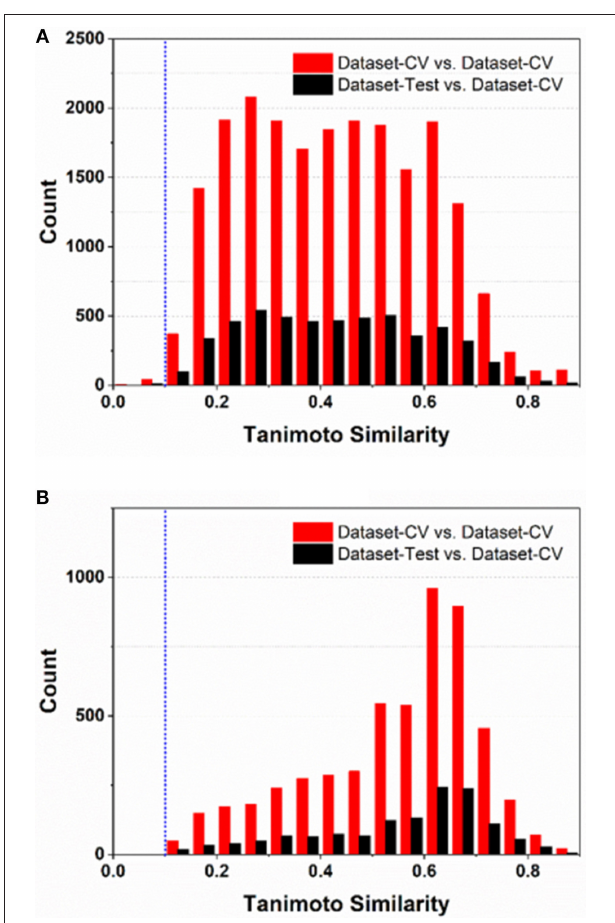
FIGURE 4 | The histograms of average-similarity are utilized to define the applicability-domain of our classification (A) and regression models (B) . Both average-similarity thresholds of 0.1 are defined and implemented in our e-Sweet platform to automatically check whether the compound to be predicted is within the applicability domain of our